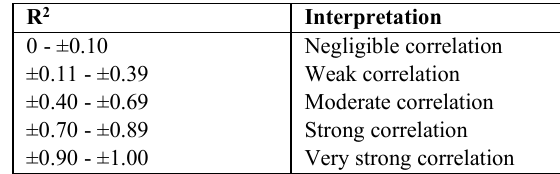
Table 3. Correlation of Coefficient and its interpretation (Schober & Schwarte,